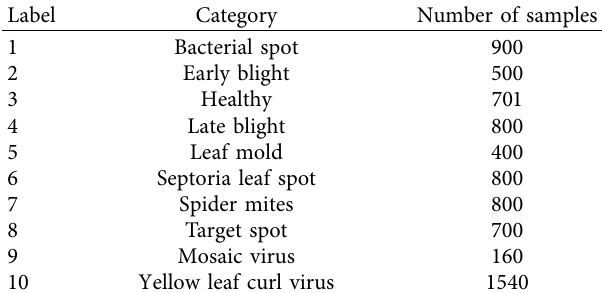
Table 1: Statistics of the dataset employed in our study.